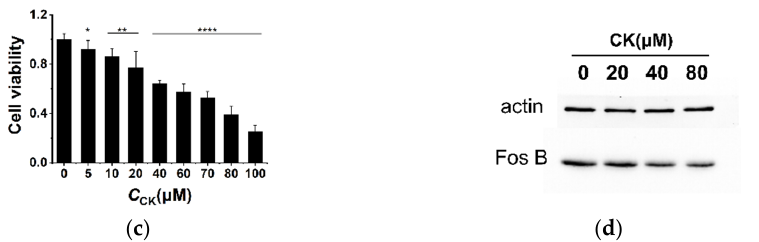
Figure 6. ( a ) The schematic illustrations of the DNA duplex template utilized for transcription. ( b ) The denatured gel electrophoresis of the transcripts of different templates in the absence and presence of CK. M90, M70, and M35 stand for linear markers with length of 90 nt, 70 nt, and 35 nt, respectively. The table below shows the variation trends of 35 nt and 70 nt transcripts in the presence of CK. ( c ) Cell viability of BEL-7402 cells after the treatment of 0, 5,10, 20, 40, 60, 70, 80, and 100 μ M CK using CCK-8 assay. * p <0.05, ** p <0.01, **** p <0.0001 vs. control. ( d ) Western blot analysis of FosB protein expression in BEL-7402 cells after the treatment of 0, 20, 40, and 80 μ M CK for 24 h.